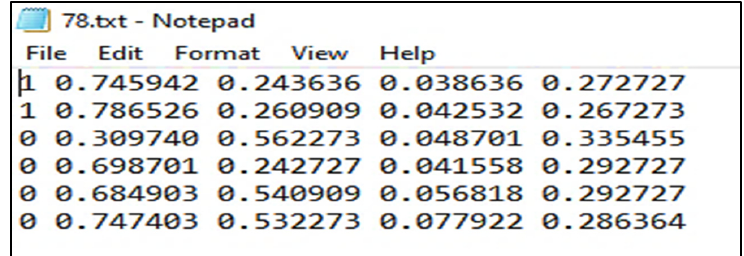
Figure 4. Labeling process with LabelImg.